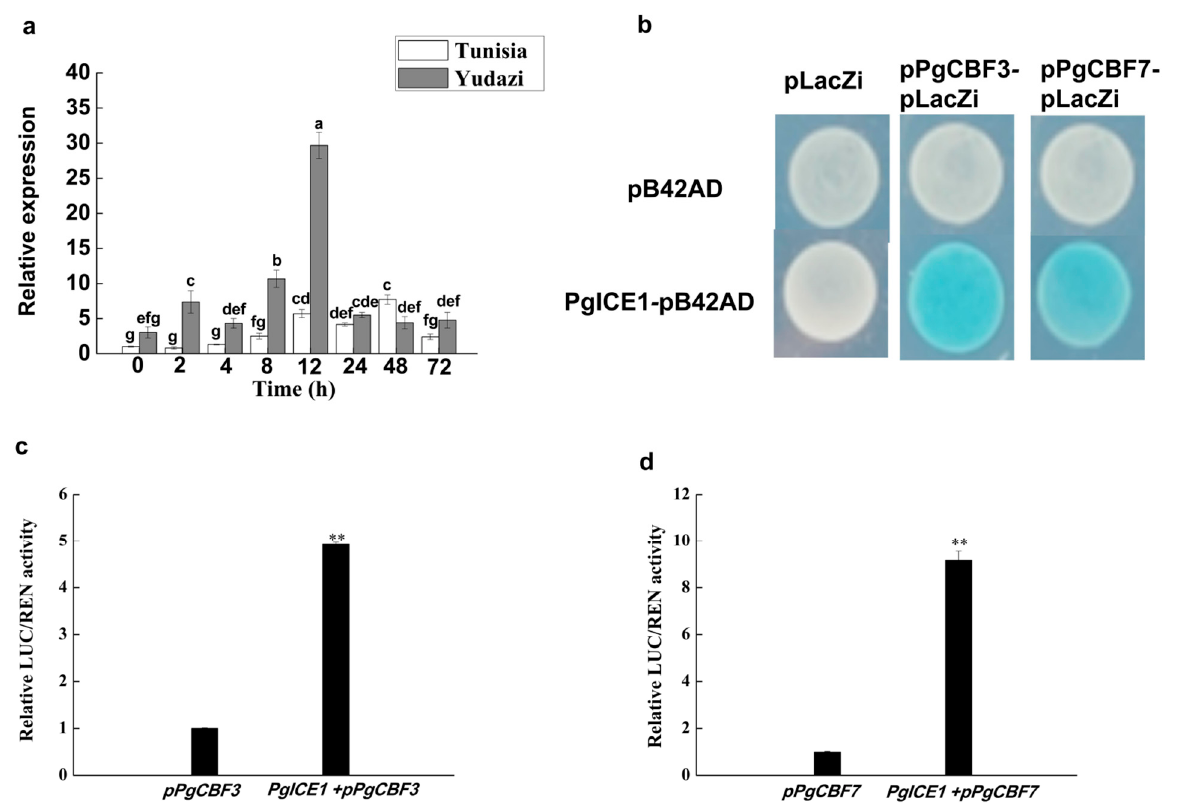
Figure 4. The expression profiles of PgICE1 gene at 4 °C and yeast one-hybrid and Dual-LUC experiment of PgICE1 on PgCBF3 and PgCBF7 promoter. ( a ) The expression profiles of PgICE1 gene at 4 °C; ( b ) Yeast one-hybrid experiment of PgICE1 on PgCBF3 and PgCBF7 promoter; ( c ) Dual-LUC activity of PgICE1 and PgCBF3 promoter; ( d ) Dual-LUC activity of PgICE1 and PgCBF7 promoter. Different letters present significant differences ( p < 0.05), and ** presents significant differences ( p < 0.01).